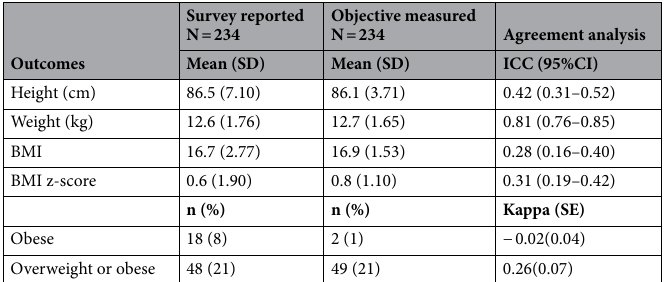
Table 2. Reported and objectively measured height, weight, BMI and BMI Z score in the sample. No significant difference was observed in the outcomes between the survey and objective measures.